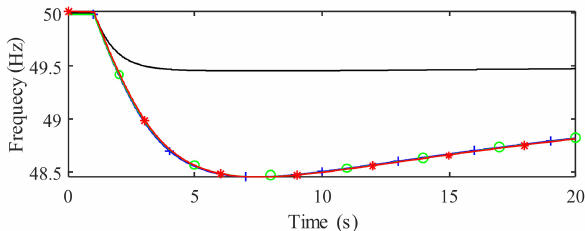
Figure 15. Comparison between frequency responses (based on SG speed variation): VSM (red, * marked), VI (green, circle marked), and droop (blue, + marked) control systems if the BESS assumed 50% of the load variation, as well as if it assumed 100% with a droop control system (black, solid